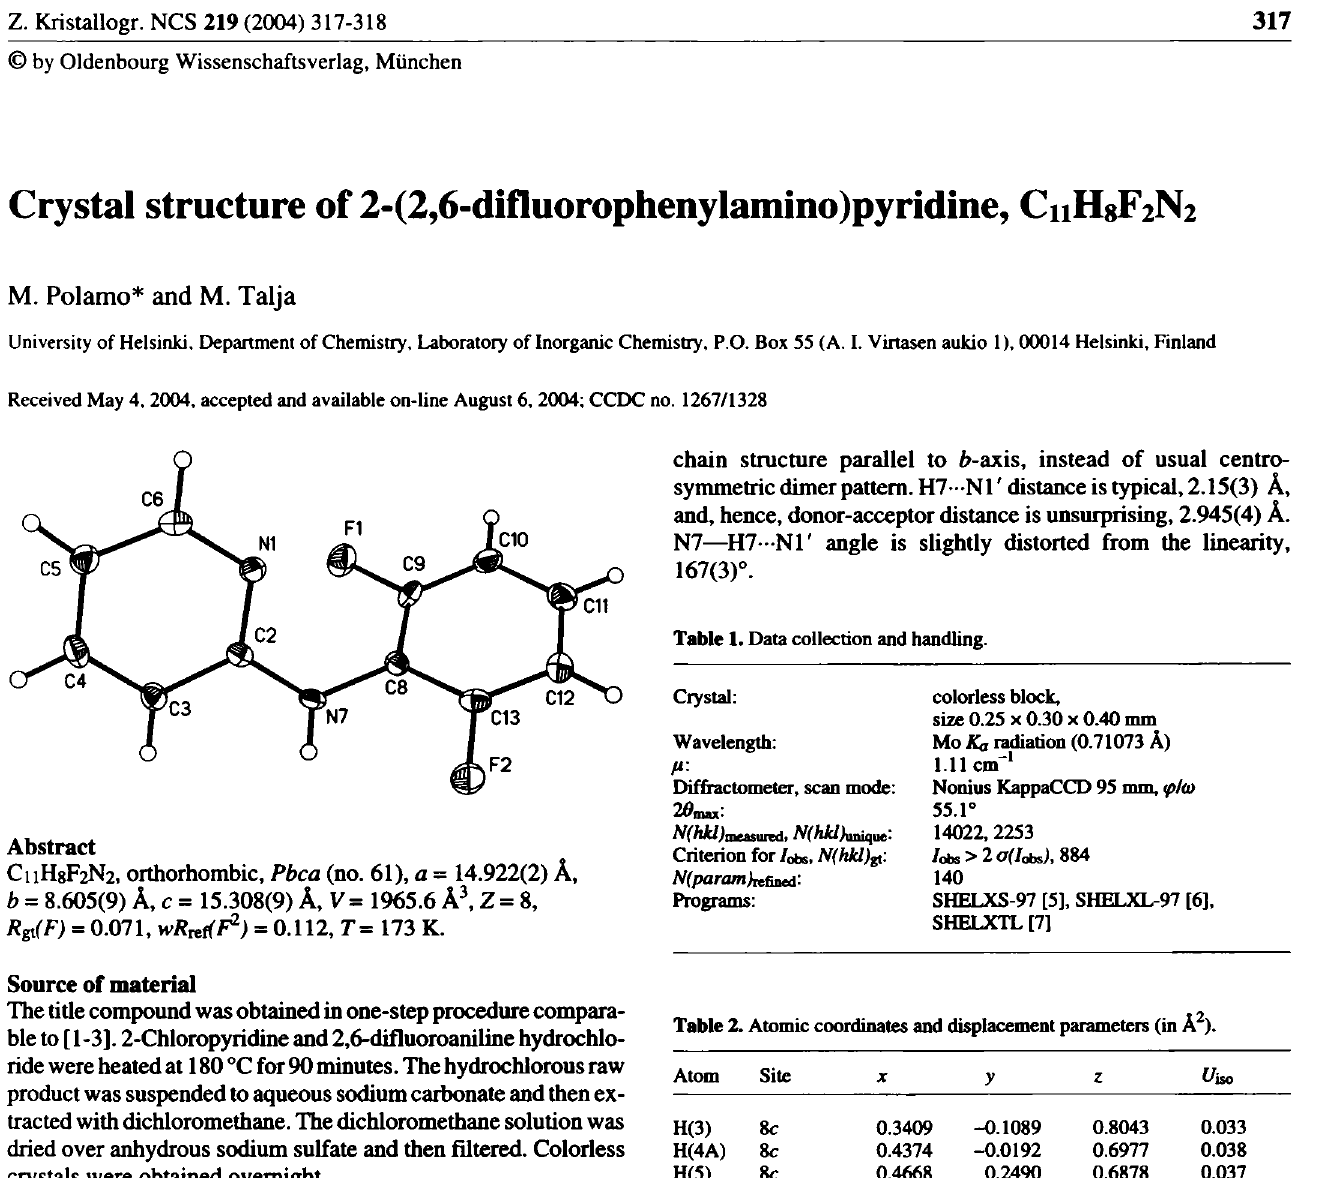
Table 2. Atomic coordinates and displacement parameters (in Â 2 ).